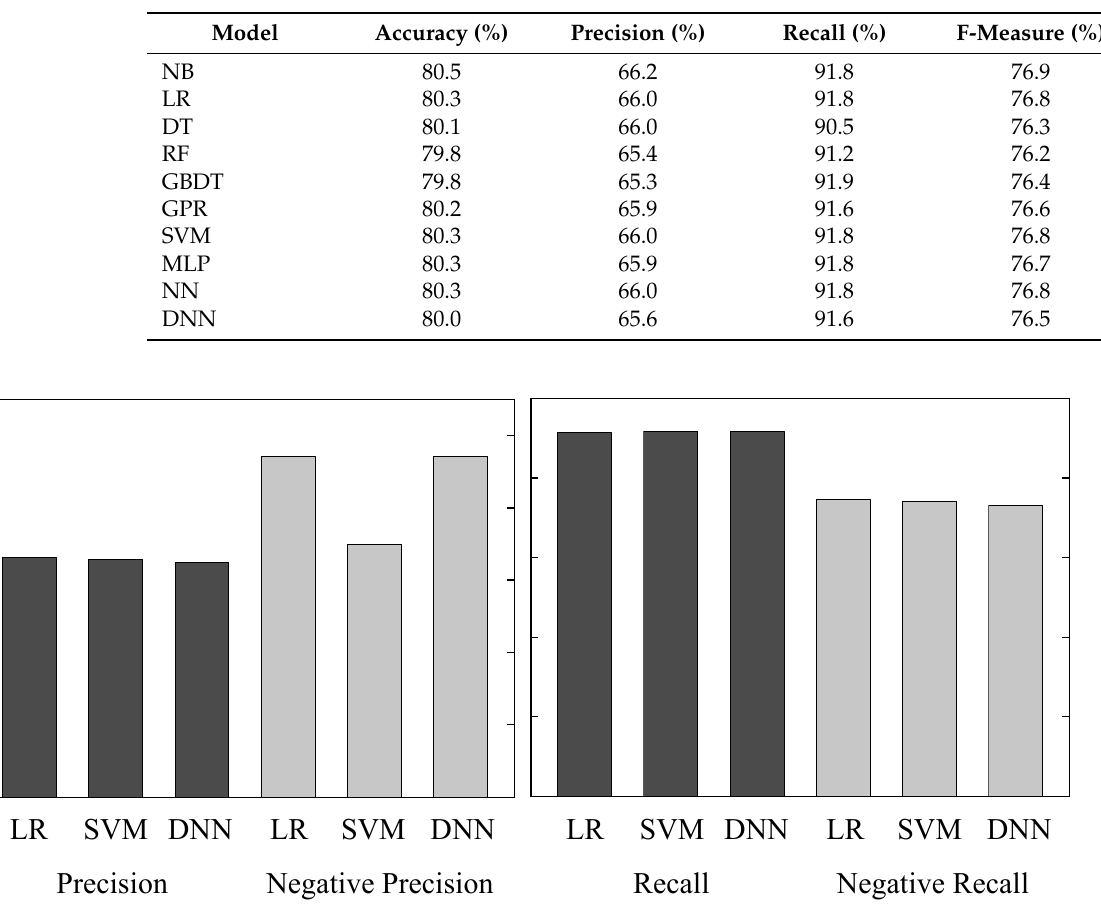
Figure 12. Comparison of Precision, Negative Precision, Recall, and Negative Recall in Section 3.9.